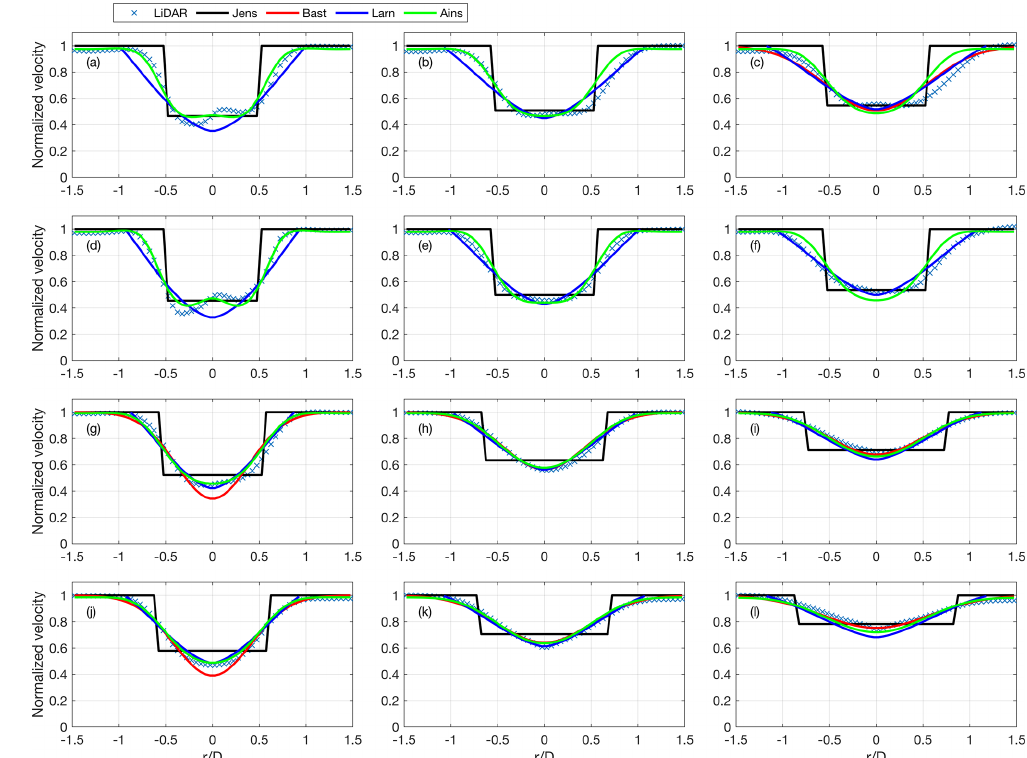
< 0 . 71 and different values hub